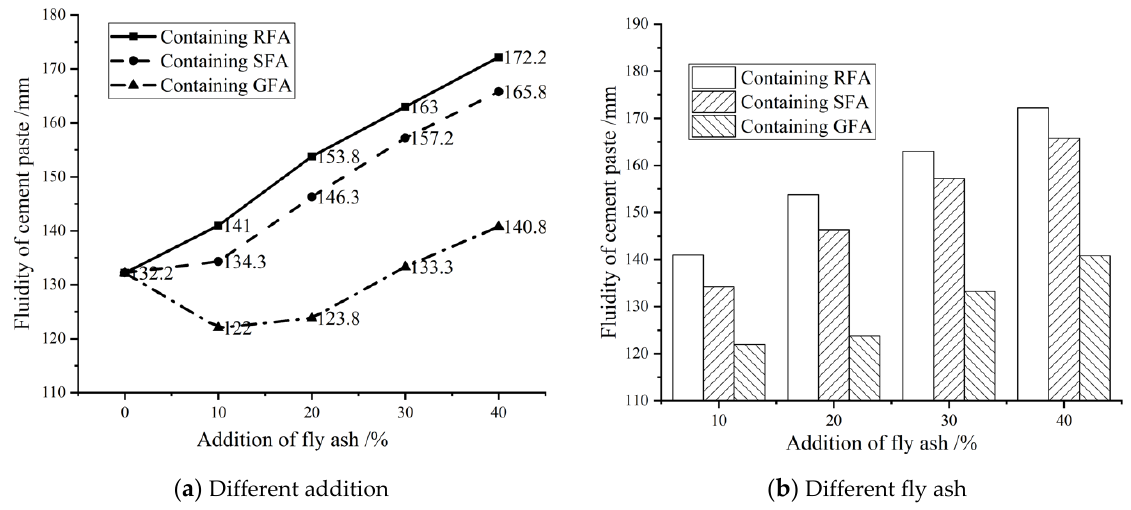
Figure 4. Fluidity of cement paste containing different fly ash.